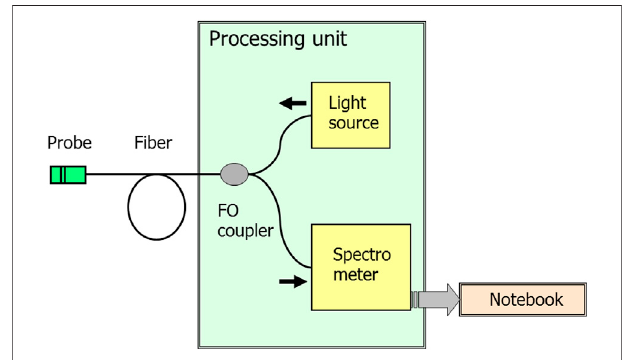
FIGURE 1 | The block scheme of the experimental setup.